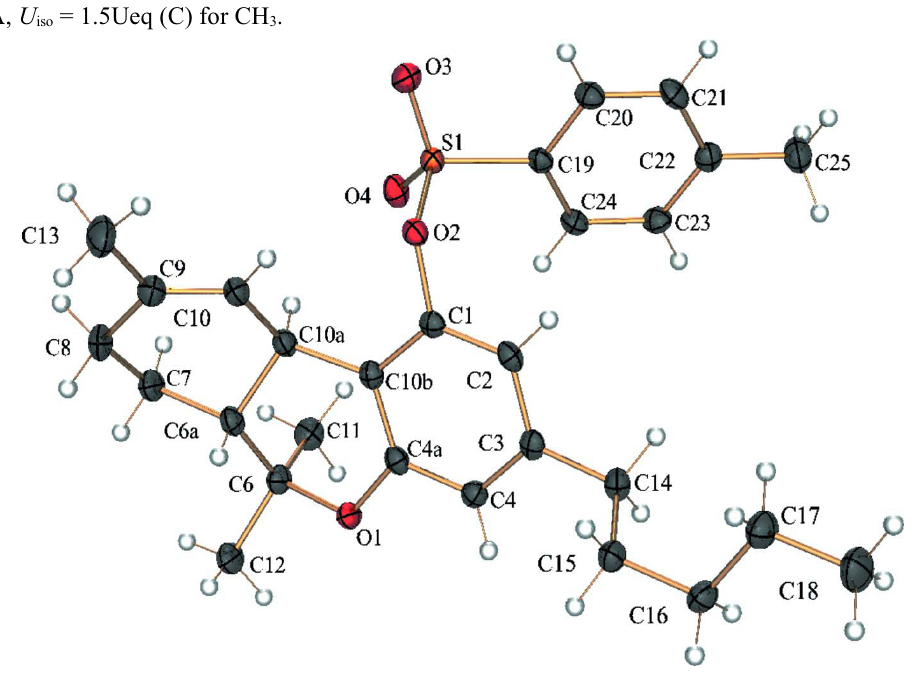
Crystal structure of the title compound with labelling and displacement ellipsoids drawn at the 50% probability